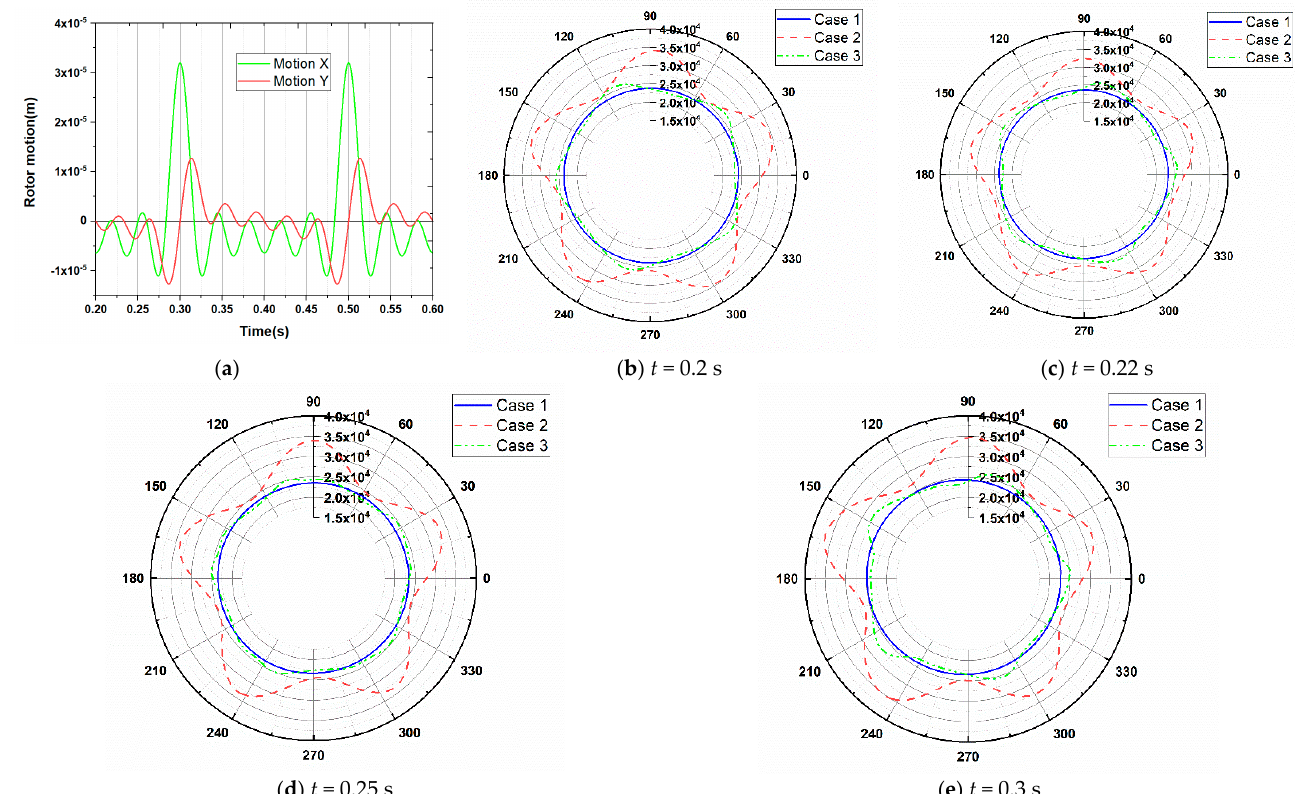
Figure 13. ( a ) Monitors of rotor motion ( x- direction excitation); ( b – e ) Circumferential pressure distributions of the rotor at different times.